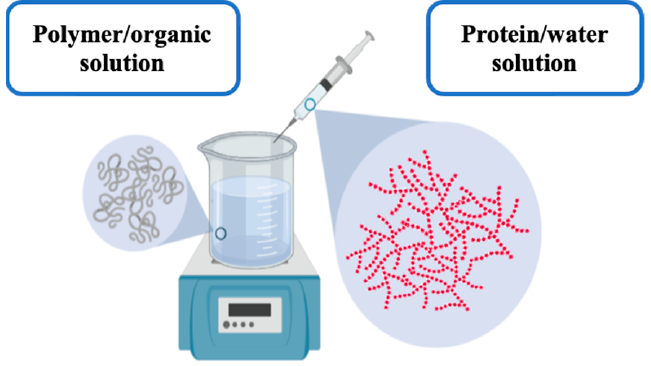
Figure 1. Simplified representation of the PLGA-based nanospheres elaboration process.